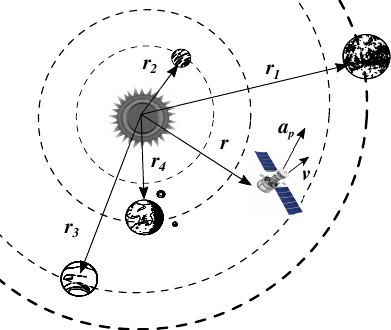
Figure 3. Perturbed Restricted N-body Problem